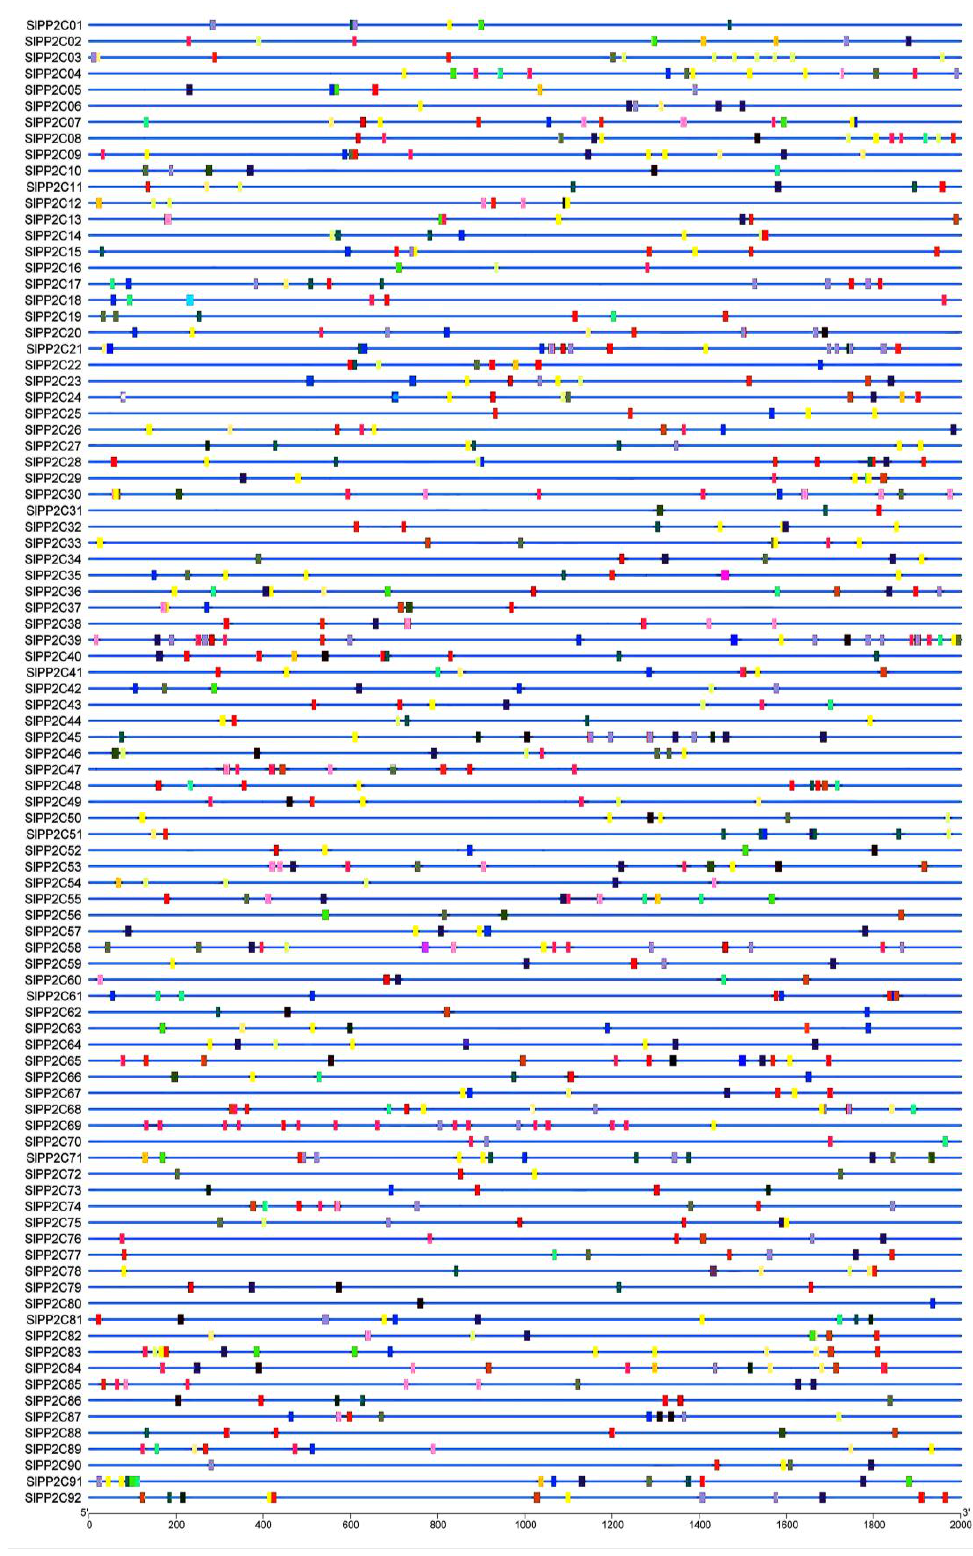
Figure 5. Identified cis-elements in the promoters of SlPP2C genes. The grey line represents the 2000 bp upstream of the SlPPCs transcription start site. Different colored wedges represent different cis-elements. The length and position of each SlPP2C gene are drawn to scale. Scale bar indicates DNA sequence length.